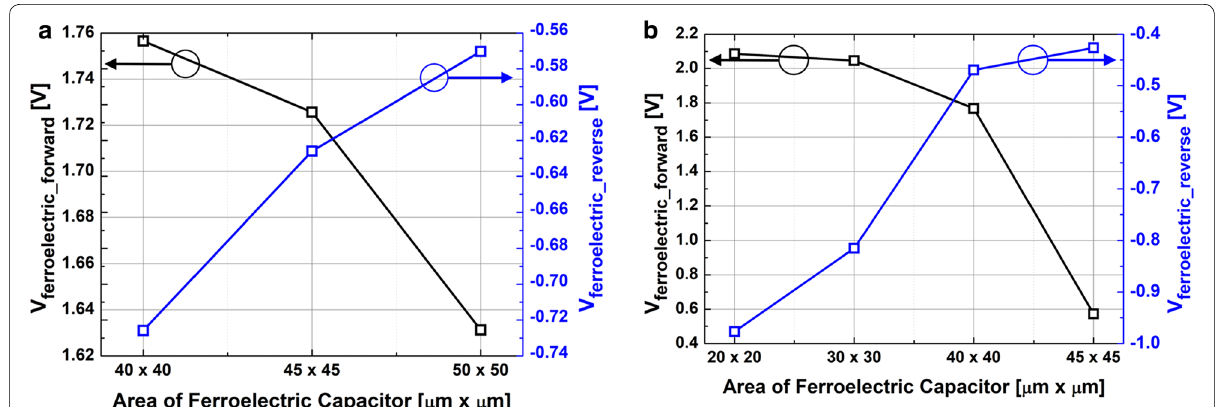
Fig. 6 Measured voltage across the ferroelectric capacitor during forward sweep and reverse sweep vs. the area of ferroelectric capacitor: a FE-FDSOI, b FE-FinFET